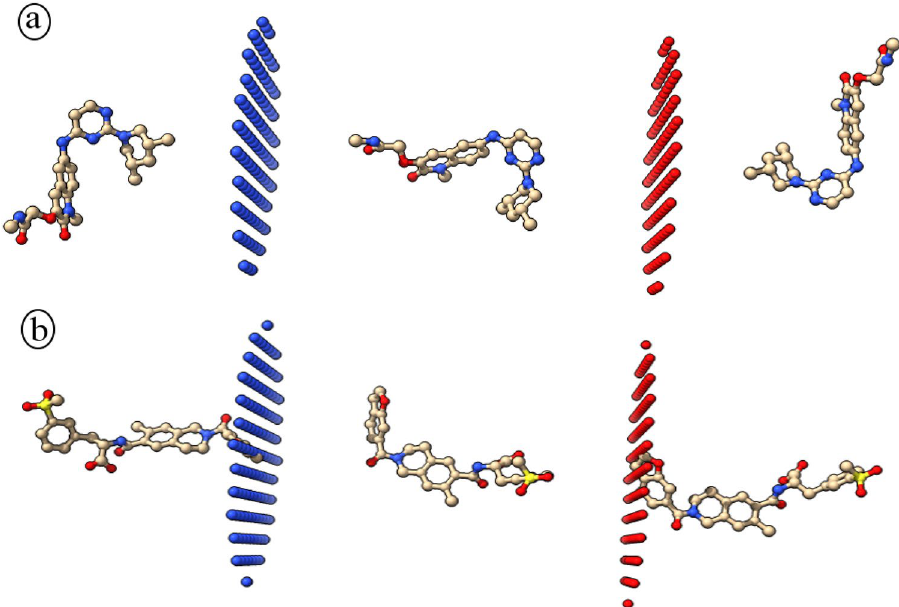
Figure 6. Schematic illustration of BI-3802 ( a ) and Lifitegrast ( b ) translocation through the membrane bilayer predicted by PerMM. The green and red plates are the outer and inner leaflets of the